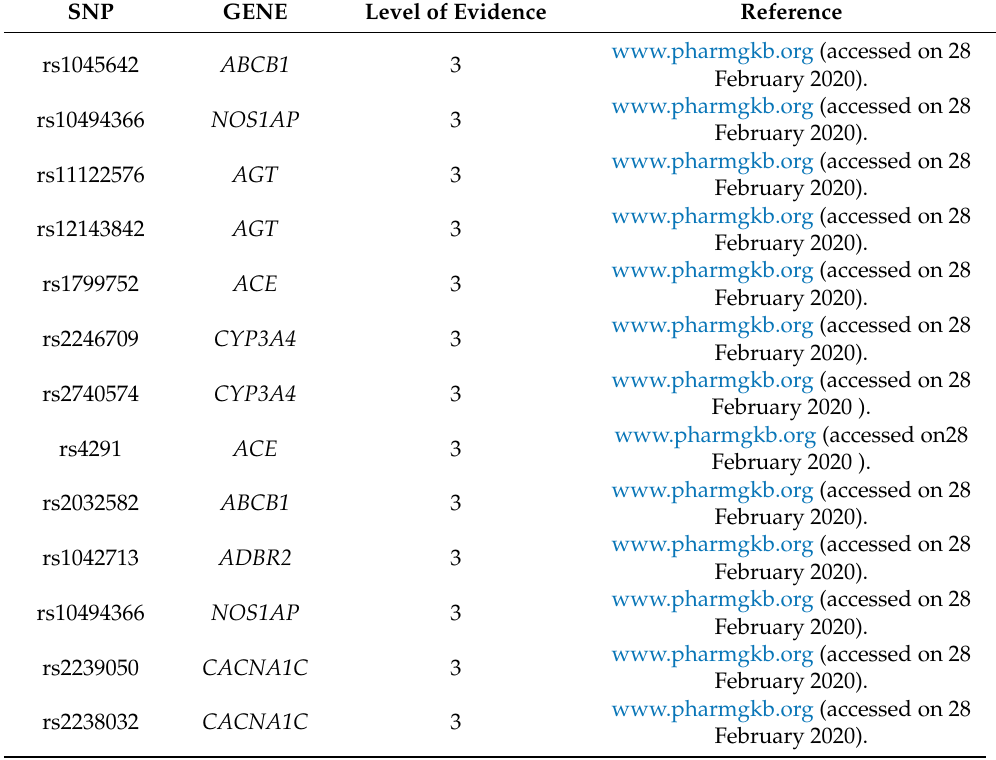
Table 1. Selected amlodipine variants used in the design of multiplex MassARRAY panels (n = 13). SNP GENE Level of